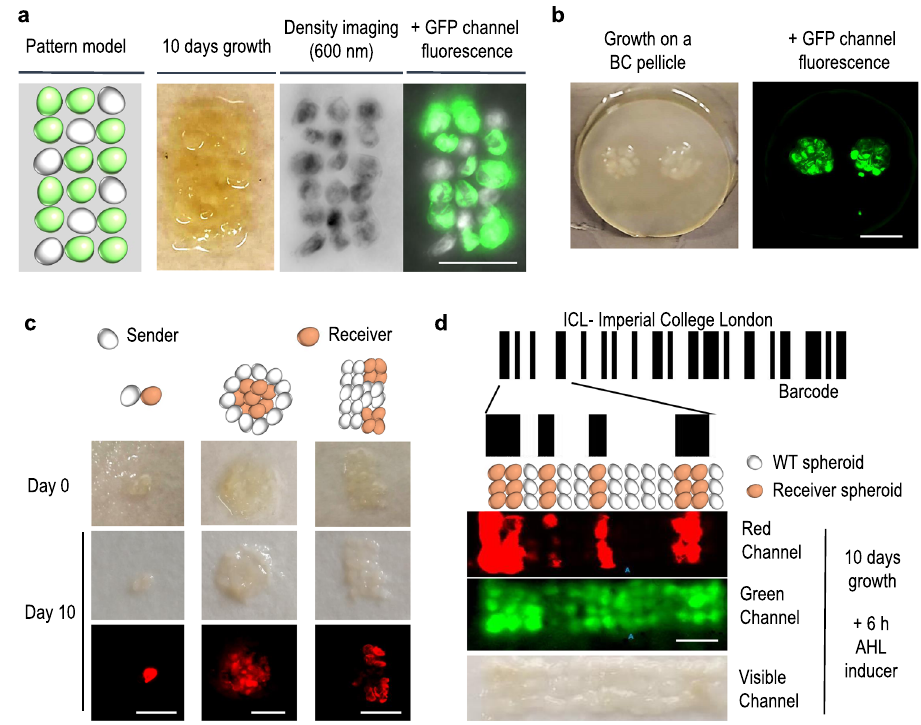
Fig. 3 Patterned materials with functionalised bacterial cellulose (BC) spheroids. a Patterns of functionalised BC spheroids produced by GFP-expressing bacteria. Intended pattern model (left), visible channel image of pellicle after 10 days growth (middle left), spheres imaged using 600 nm excitation laser (middle right) and the merged 600 nm image and green fl uorescence imaging channel (far right). b Mosaic of GFP-expressing BC spheroids grown for 4 days at 30 °C on an existing bacterial cellulose pellicle. Images of the material after 10 days of growth in the visible channel (left) and green fl uorescence channel (right). c Patterns built with two different genetically functionalised spheroids that secrete (sender) and respond (receiver) to acyl-homoserine- lactone (AHL). Receiver spheroids express RFP in response to AHL produced by neighbouring sender spheroids. Image of initial patterned material (top), visible channel image after 10 days (middle) and red green fl uorescence channel after 10 days (bottom). d Example of a functionalised BC spheroid pattern; a chemically responsive barcode. The Code-128 barcode for ICL (Imperial College London) was generated and a section of this was recreated as a BC pattern using a grid of 14 × 3 spheroids grown from either wild-type bacteria or the receiver bacteria used in c . Spheroids were grown for 10 days into a continuous material appearing white/brown to the naked eye. Soaking this in 25 nm AHL for 6 h triggered RFP expression from the receiver bacteria in the pattern. The hidden barcode pattern is then revealed by scanning for red fl uorescence, whereas scanning for green fl uorescence only reveals the spheroid density. Scale bars are 5